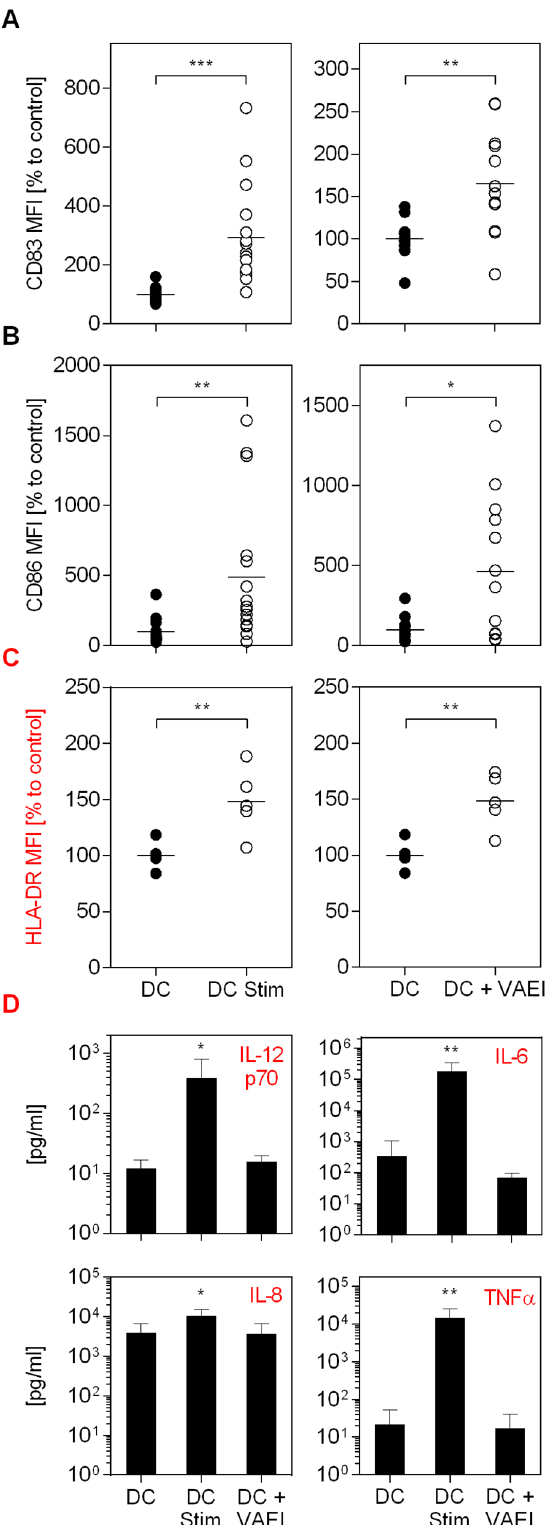
Fig 1. Influence of VAEI on DC maturation and cytokine secretion. CD14 + monocytes were matured to immature DC and incubatedwith medium (DC), maturation cocktail (DC Stim; 500 ng/mL LPS; 50 ng/mL